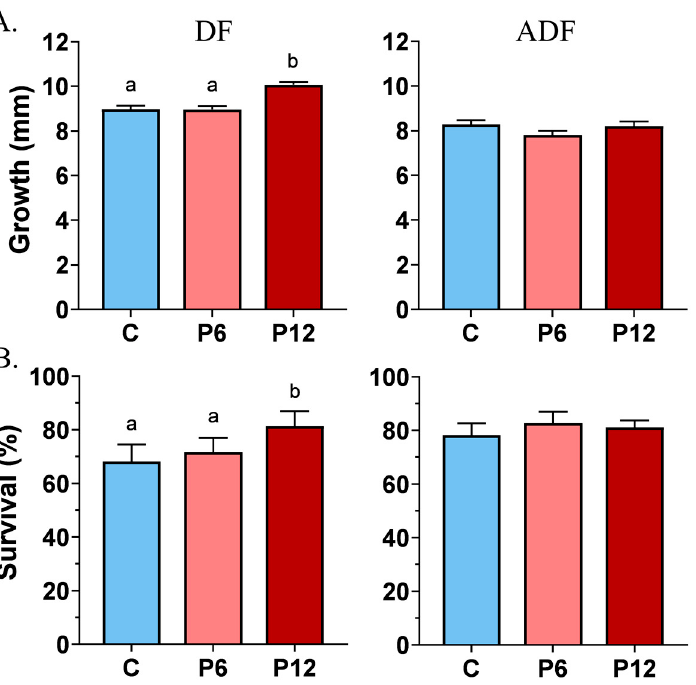
Figure 3. Effect of peptide diets (C, P6, P12) on the mean growth ( ± SE) ( A ) and survival ( ± SE) ( B ) at Figure 3. E ff ect of peptide diets (C, P6, P12) on the mean growth (±SE) ( A ) and survival (±SE) ( B ) at the end of the larval stage in the two feeding regimes (DF, ADF). Statistically significant differences the end of the larval stage in the two feeding regimes (DF, ADF). Statistically signi fi cant di ff erences between the diets are indicated by the absence of a common letter ( p < 0.05). between the diets are indicated by the absence of a common le tt er ( p < 0.05). Feeding regime DF highlighted also that peptide diet P12 induce a statistically sig- 3.3. P12 Diet Reduces the Abnormalities Rates When Dry Feeds Are the Sole Feeding Source nificant higher survival rate reaching 81.4 ± 5.6%, compared with P6 (71.7 ± 5.3%) and C The most frequent abnormality types observed in our samples include an inner fold- (68.1 ± 6.3%) (Figure 3B, DF). Concerning the ADF trial, no differences on survival rates ing of the gill-cover (Figure 4A,A ′ ), prehaemal kyphosis (Figure 4B), missing and com- were observed between the diets, whereas the range of the survival frequencies varied from pressed caudal fi n rays (Figure 4C) or a between the lepidotrichia hemirays split accom- 78.2 ± 2.6% (P6) to 81 ± 1.4% (P12) and 82.7 ± 2.5% (C) (Figure 3B, ADF). panied by poor lepidotrichia ossi fi cation (Figure 4D,D ′ ). Prehaemal kyphosis and caudal- No significant replicate effects were observed for both growth and survival rates in peduncle scoliosis (Figure 4E) prevailed over the vertebrae deformities. Additionally, an the two feeding regimes (Supplementary Figure abnormal formation of anal pterygiophores (Figure 4F) was observed. DF highlighted the bene fi cial e ff ect of P12 on the gill cover abnormalities (Left gill cover, 10.2 ± 0.3 and Right gill cover, 8.9 ± 0.4) compared with P6 (L, 18.2 ± 0.4 and R, 17.5 ± 0.3) and C (L, 19.8 ± 0.3 and R, 16.9 ± 0.3) (Figure 5A,B, DF). In addition, both P6 and P12 of the same regime resulted in lower kyphosis incidents, 28.4 ± 0.5 and 24.6 ± 0.5, respec- tively, in contrast with the C diet (39.3 ± 0.9) (Figure 5C, DF). Under the same DF regime, increased number of individuals with abnormal anal pterygiophores were reported in P12 (33.8 ± 0.6) (Figure 5F, DF). On the other hand, feeding regime ADF led to decreased rates of below 15% concerning every abnormality type regardless of the diet (Figure 5A–F, ADF).